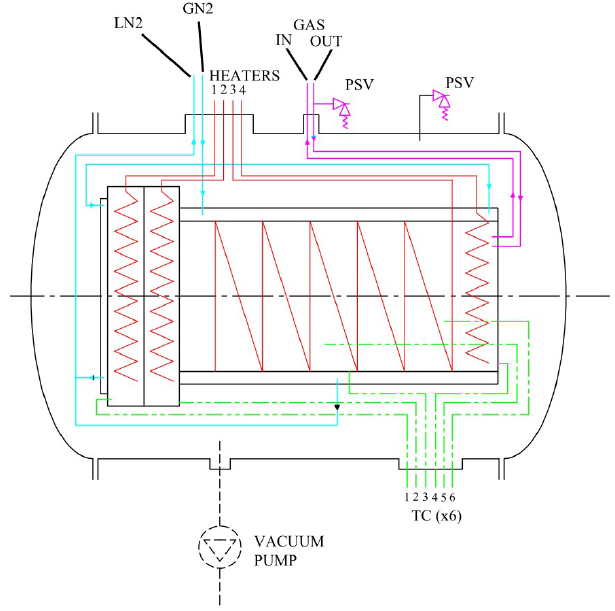
Figure 2. Schematic view of the subsystems. The heaters are in- dicated in red, the liquid nitrogen circuit in blue (LN2 and GN2 indicate liquid nitrogen input and output), the thermocouples (TC) in green, and gas supply lines in violet. PSV indicates the pressure valves on the gas inlet and outer chamber.